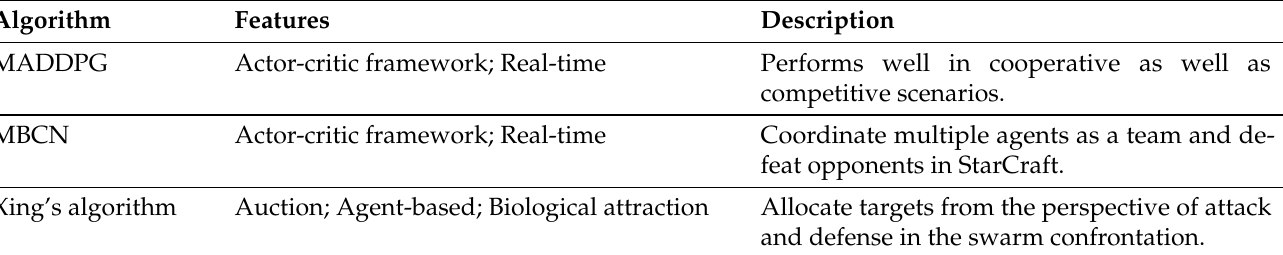
Table 1. Algorithms for UAV swarm